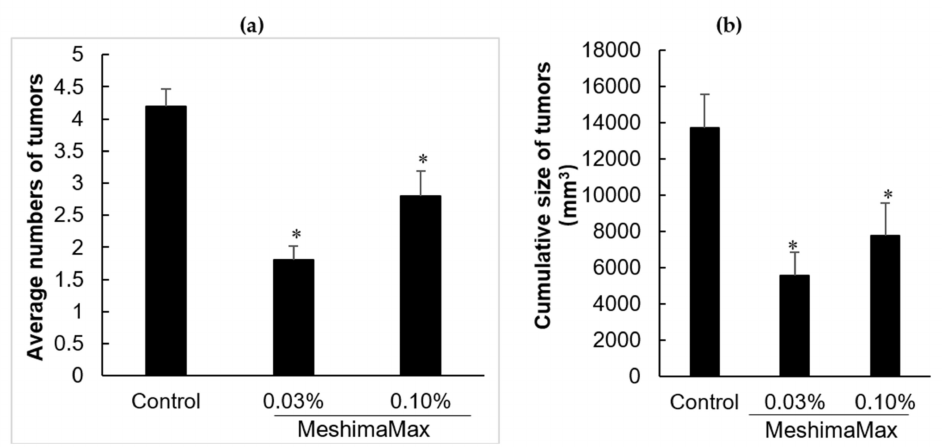
Figure 2. Suppression of tumor development by MeshimaMax in DBMA treated rats. ( a ) Average numbers of breast tumors developed; ( b ) Cumulative size (tumor volume) of breast tumors. Data are those at day 206 after MeshimaMax treatment. * P < 0.05 vs Control. Data are mean ± SD, n = 5–6.